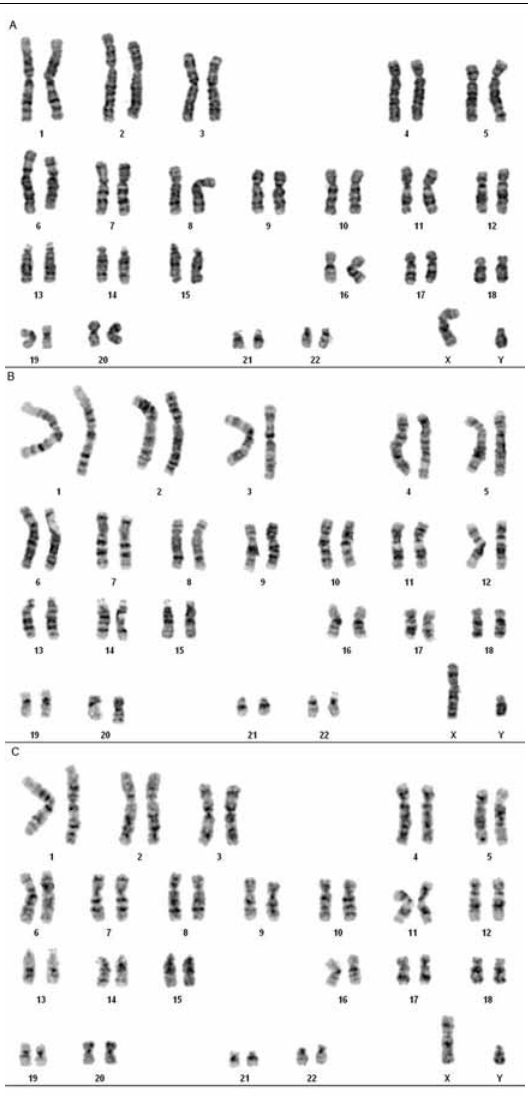
figurE 3 – Metaphases obtained from lymphocytes cultured at different times, GTG banding A) 0 h with 500 bands; B) 24 h with 450 bands; C) 48 h with 350 bands.